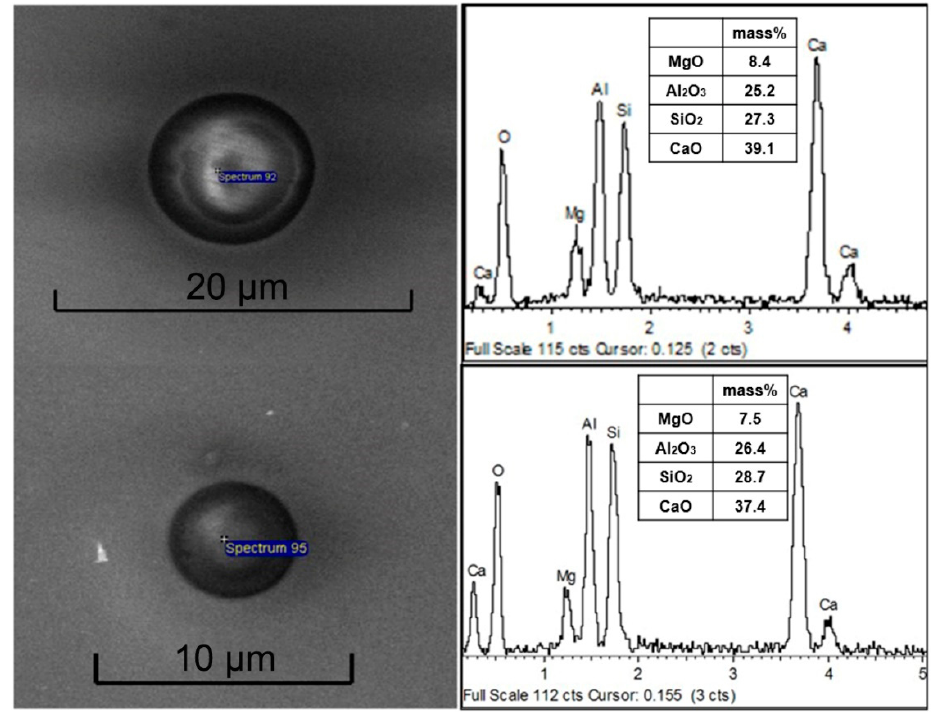
Figure 3. SEM images and EDS results of inclusions in the samples taken at AOD tapping when using ordinary FeSi alloy.